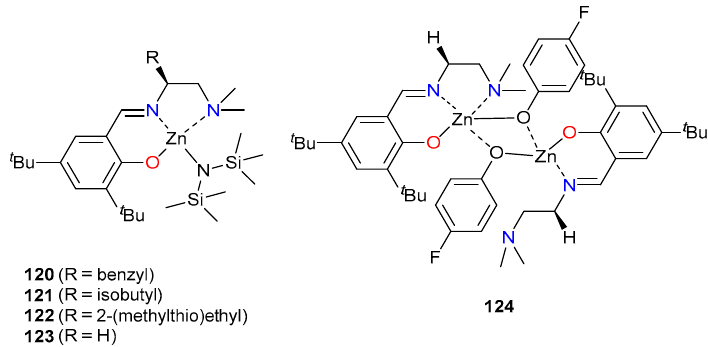
Figure 21. Amino-acid based Zinc Catalysts 120–124 [77].